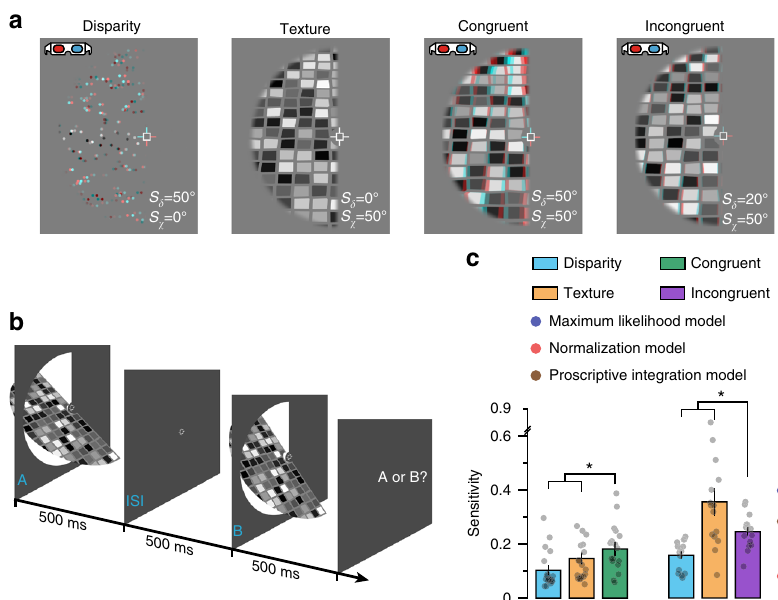
Fig. 3 Psychophysical measurements of cue integration. a Single- and (congruent/incongruent) combined-cue stimuli designed for use with red – cyan anaglyphs. b Presentation sequence used to psychophysically assess cue integration: observers judged whether the fi rst or second stimulus was more slanted. c Behavioural sensitivity (the reciprocal of the just noticeable difference in degrees) for slant de fi ned by disparity, texture, and congruent and incongruent combinations of these cues. We assessed the statistical signi fi cance in congruent and incongruent conditions using RM ANOVAs. In both cases we found signi fi cant main effects of stimulus type (congruent: F 2,34 = 7.92, P = 0.002; incongruent: F 2,28 = 10.68, P = 0.002). We followed this with paired t -tests to compare individual stimulus conditions; asterisks highlight signi fi cant differences P < 0.05 (congruent disparity: t 18 = 3.85, P =